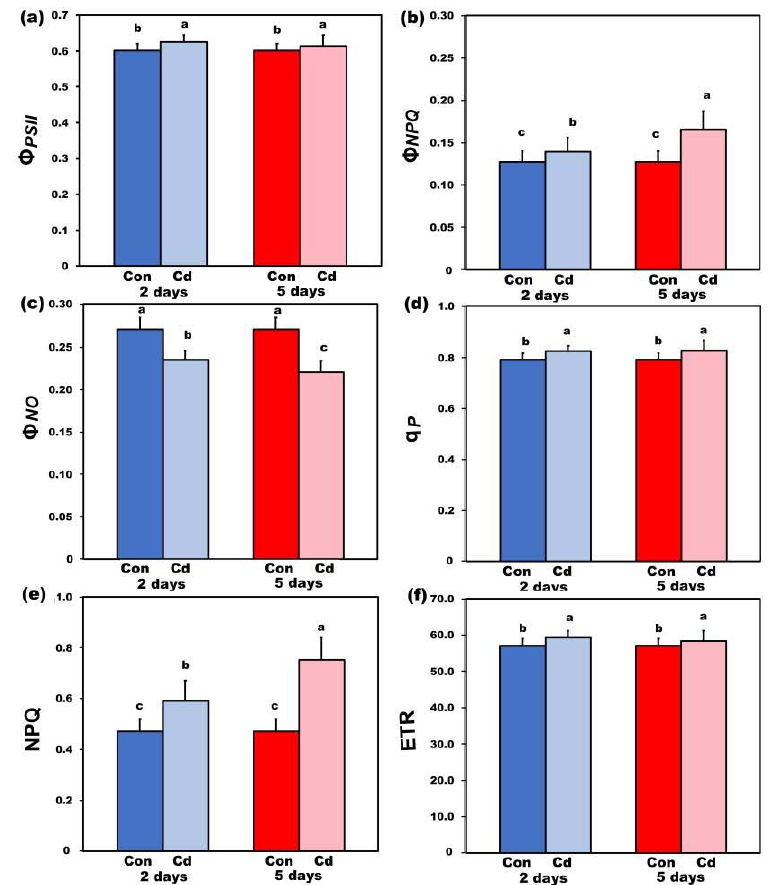
Figure 5. Changes in the quantum efficiency of PSII photochemistry (Φ PSΙΙ )( a ), the quantum yield of regulated heat dissipation in PSII (Φ NPQ ) ( b ), the quantum yield of non-regulated energy dissipated in PSII (Φ NO ) ( c ), the fraction of open PSII reaction centers ( q P ) ( d ), the non-photochemical quenching (NPQ) ( e ) and the electron transport rate (ETR) ( f ), measured at 220 μmol photons m −2 s –1 ; of control (con) and 2- and 5-days Cd-treated Salvia sclarea plants. Error bars are standard deviations ( n = 6). Columns with different letters are statistically different ( p < 0.05).